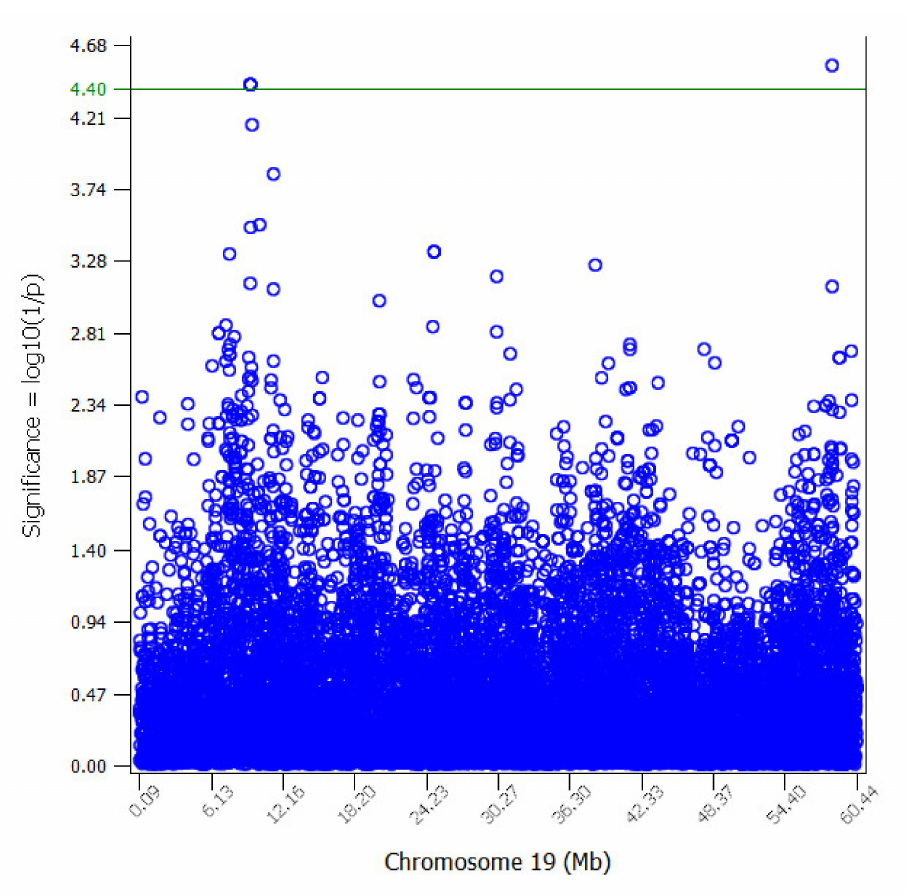
Figure 1. Manhattan plot of chromosome-wide association study of the corrected phenotype of so- matic cell score (SCS) trait in Assaf sheep for chromosome Oar19. The chromosome-wide significance level was established at values above log10 (1/ p ) (observed value) >4.40 (FDR p <